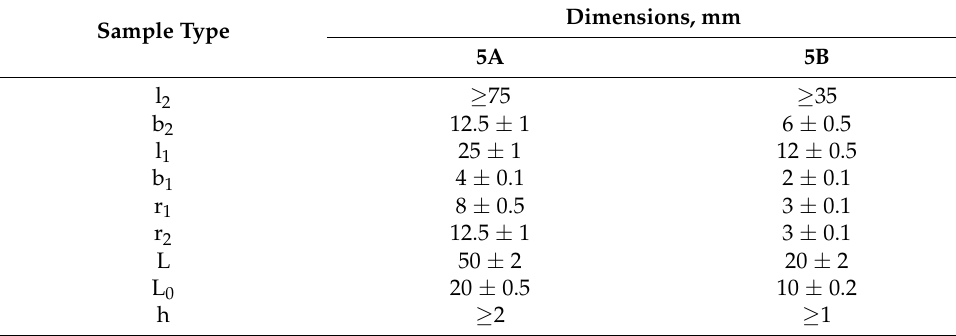
Table 3. ISO 527-1:1993 specimen